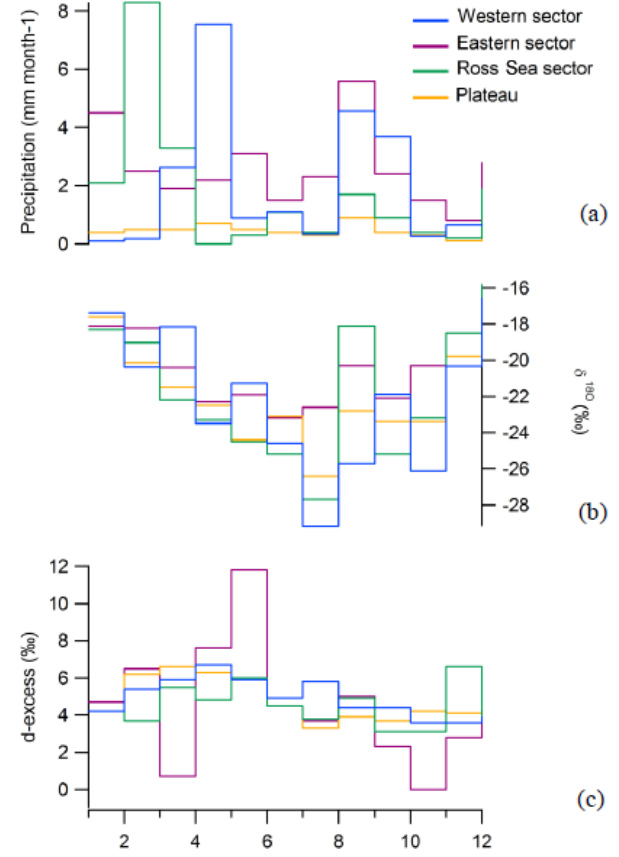
Figure 10. Seasonal cycles of precipitation (mmmonth − 1 ). (a) δ 18 O (‰, b ), and d -excess (‰, c ) simulated by ECHAM5- wiso by back-trajectory regions: (i) the eastern sector (0–66 ◦ S, 0– 180 ◦ E), (ii) the plateau (66–90 ◦ S, 0–180 ◦ E), (iii) the Ross Sea sector (0–75 ◦ S, 180–240 ◦ E), and finally (iv) the western sector (0– 75 ◦ S, 180–240 ◦ E) and (50–90 ◦ S, 240–360 ◦ E) (see Sect.